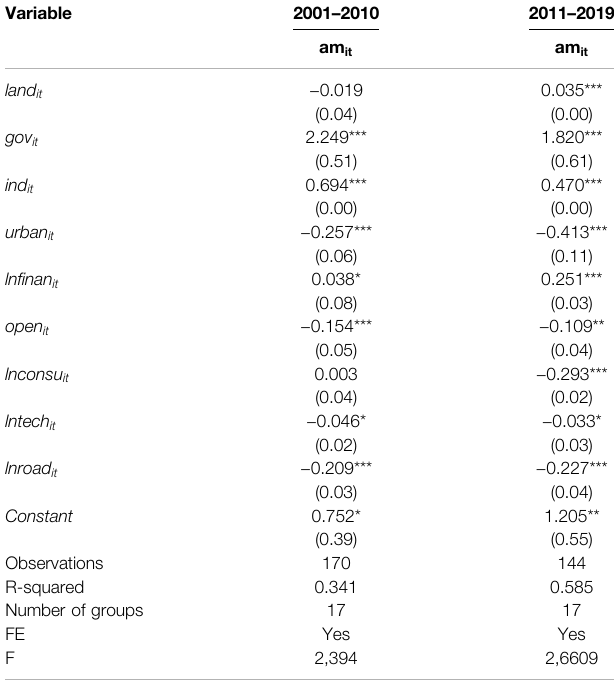
TABLE 2 | Temporal heterogeneity effects of the multidimensional contributing factors of the SMCL.